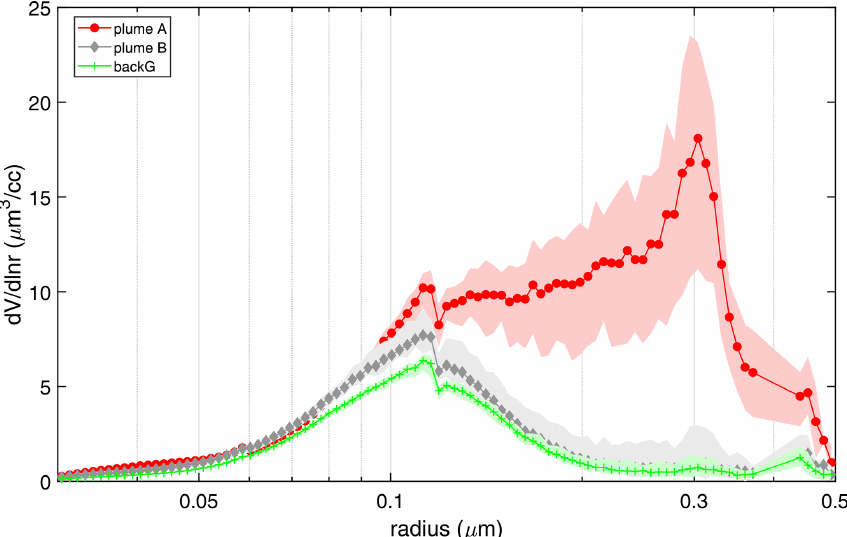
Figure 5. Averaged UHSAS volume PSDs during screen 1 on 9 June. Colour patches represent variations with altitude while solid lines show the screen-averaged PSDs for plumes A and B as well as the background (out-of-plume)